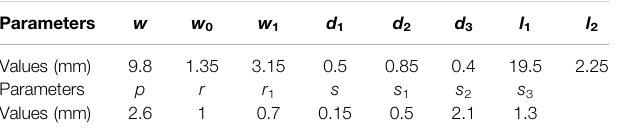
TABLE 1 | Parameters of the Proposed BPF with A Notch Band. Parameters